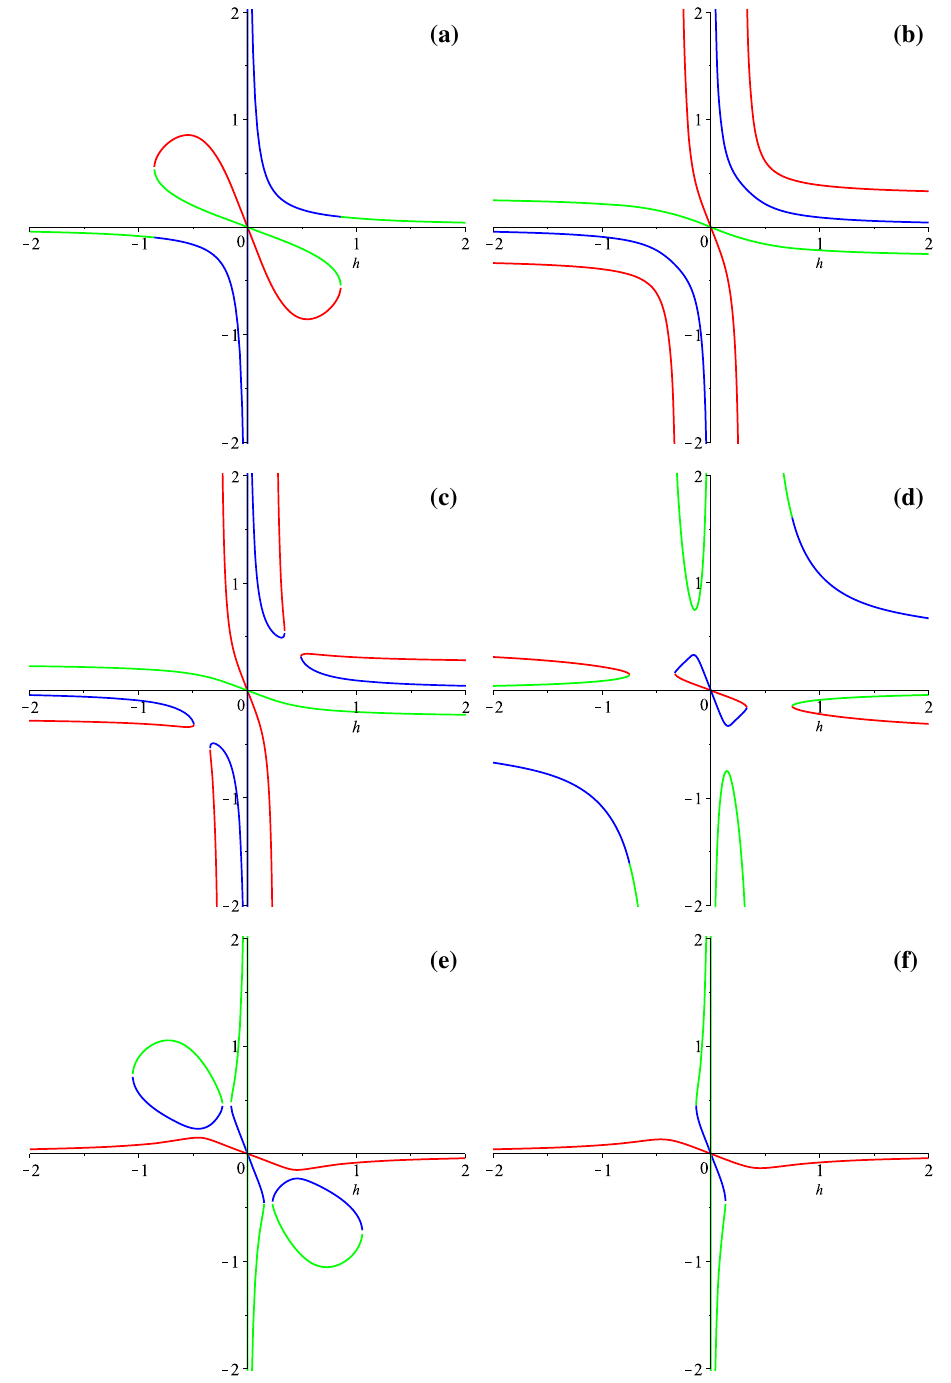
Fig. 1 H ( h ) graphs for vacuum D = 3 case: three different colors correspond to three different branches H 1 , H 2 and H 3 ; α < 0, β < 0 on a panel, α < 0, β > 0, μ < 3 / 2 on b panel, α < 0, β > 0, μ > 3 / 2